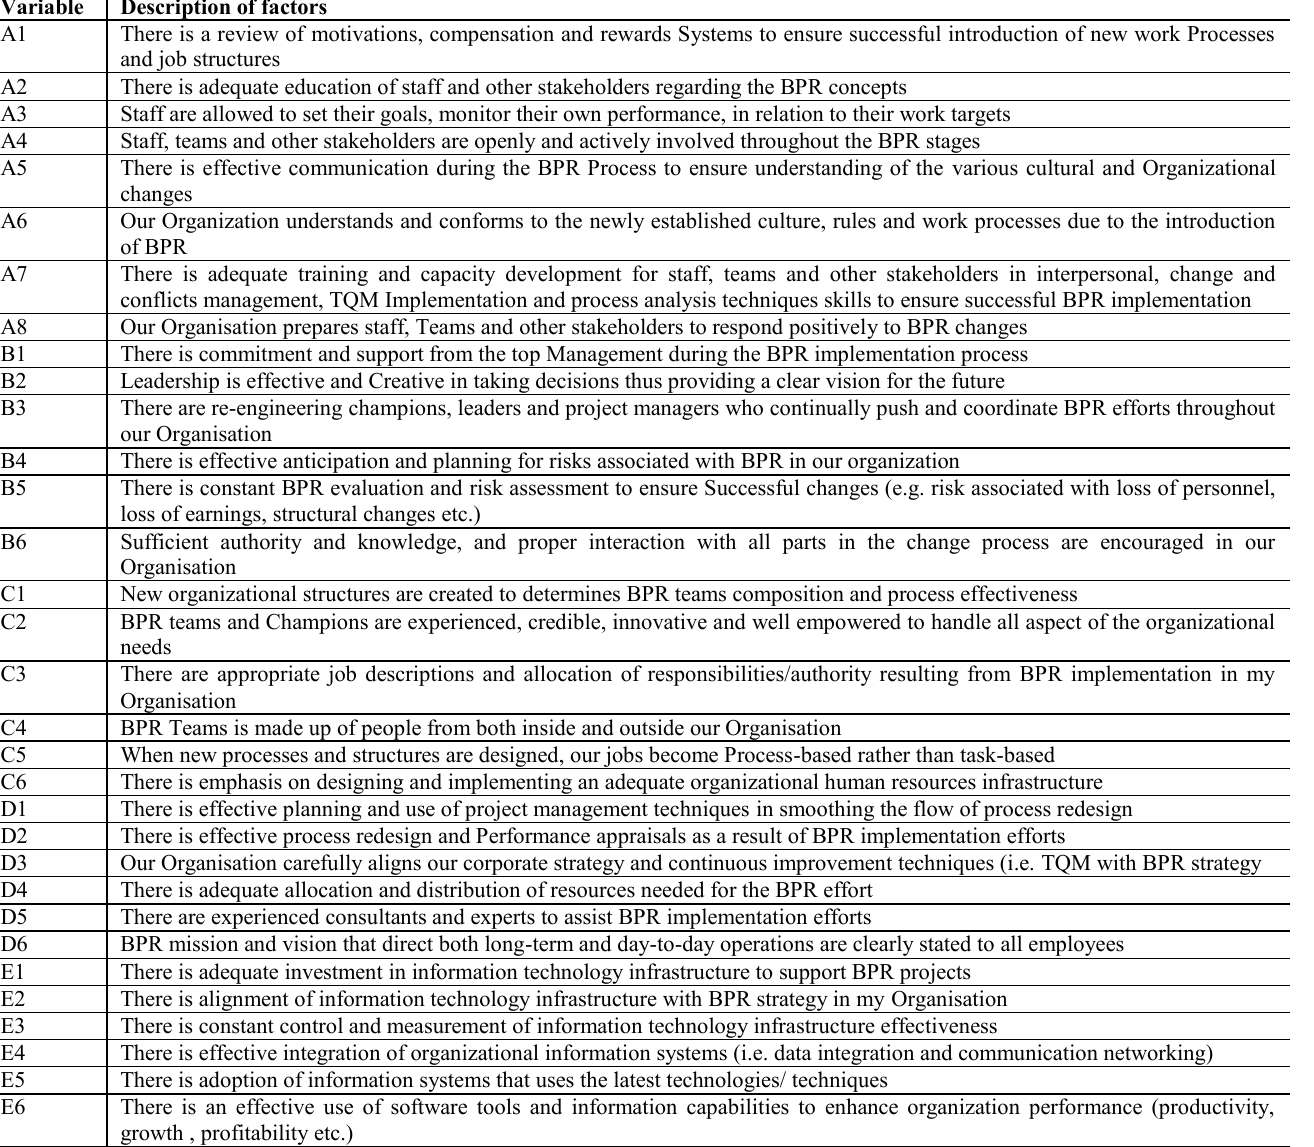
Table 1: The measure of CSFs of BPR